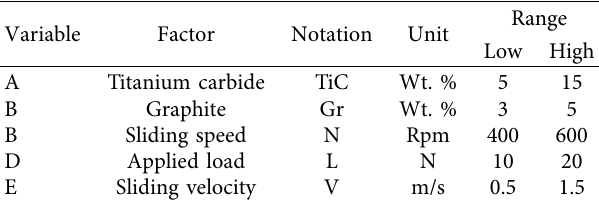
Table 2: Process parameters and their